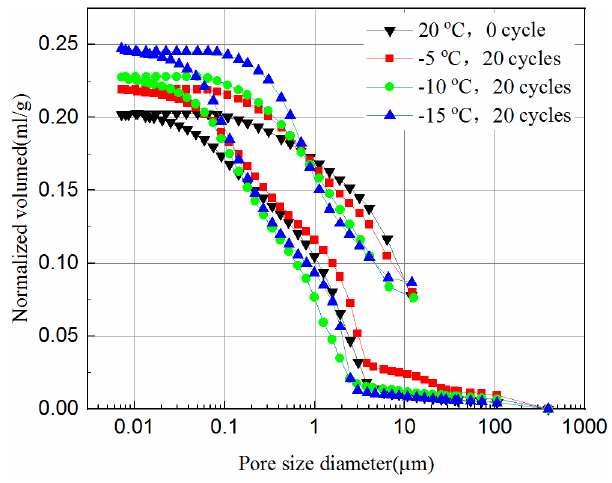
Figure 11. Intrusion and extrusion curves of 28-day samples at different cooling temperature.